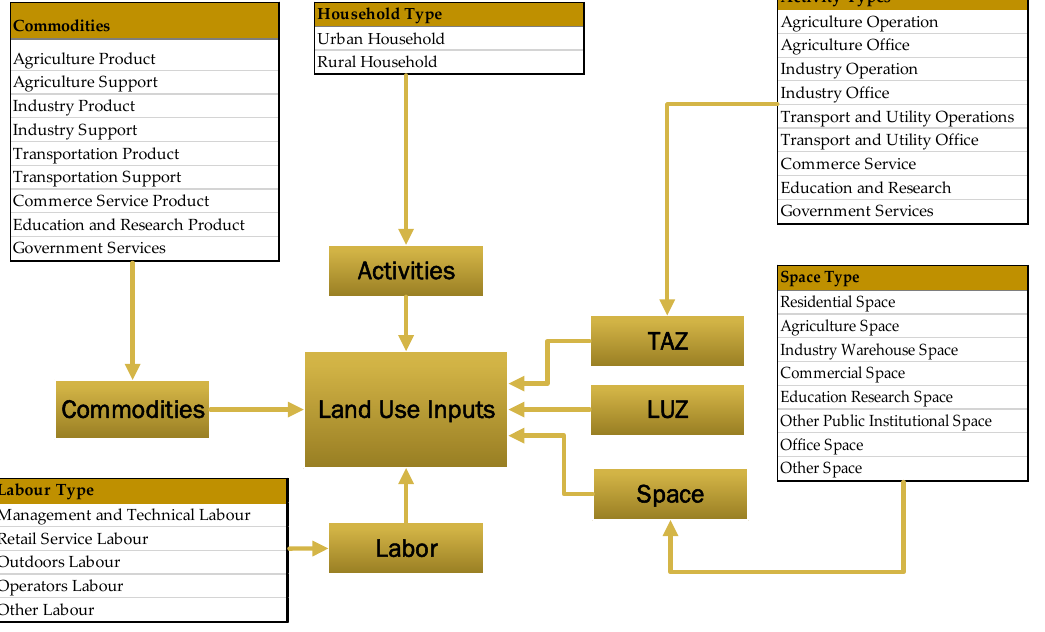
Figure 3. Land use input data.